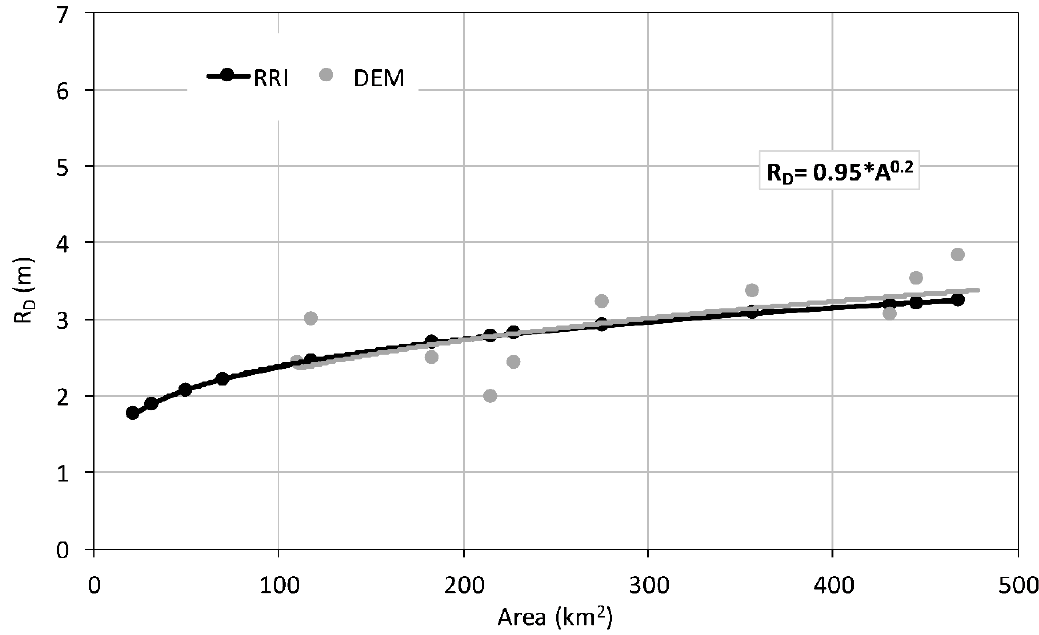
Figure 4. The relationship between the river basin area (A) and river depth (R D ) for the Oda river basin. Black and gray points with fitted black and gray lines indicate the default R D -A relationship based on the RRI model and DEM data, respectively.